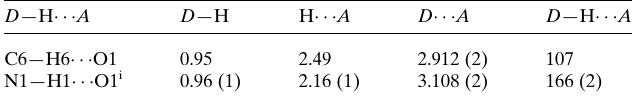
Table 1 Hydrogen-bond geometry (A˚ , (cid:2) ) for TFMP .